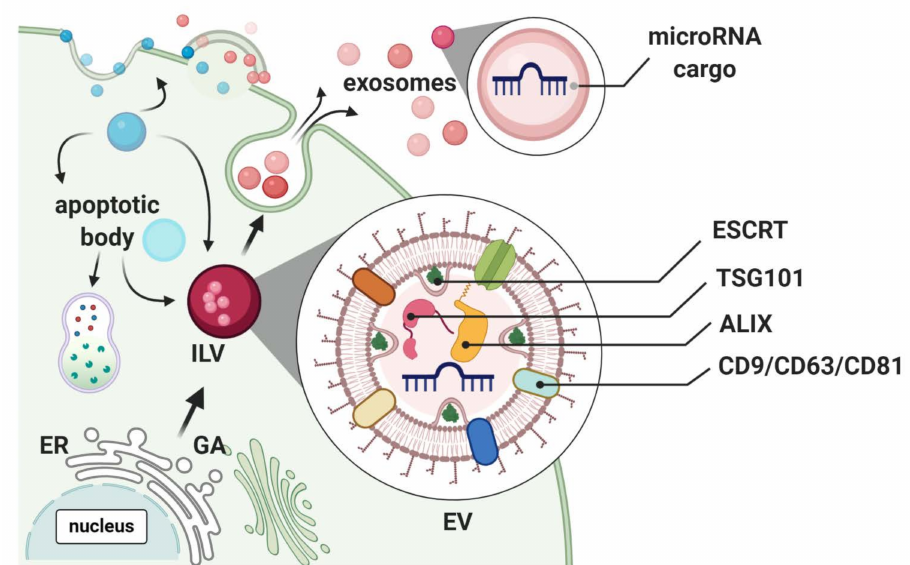
Figure 3. Extracellular vesicle (EV) generation and secretion. Molecules from extracellular space fuse with the plasma membrane, and reach the endosome, which buds inwardly to form intraluminal vesicles (ILV), which then transform into multi-vesicle bodies (MVBs). MVBs further fuse with the plasma membrane of late endosomes and release vesicles named exosomes into the outer space . Exosomes receive cargo through the endosomal sorting complex required for transport (ESCRT). Di ff erent types of exosomes can be discriminated not only by cargo type but also by di ff erent surface markers (CD63, CD9, CD81), or the tumor susceptibility gene 101 (TSG) 101 and the apoptosis-linked-gene-2 interacting protein X